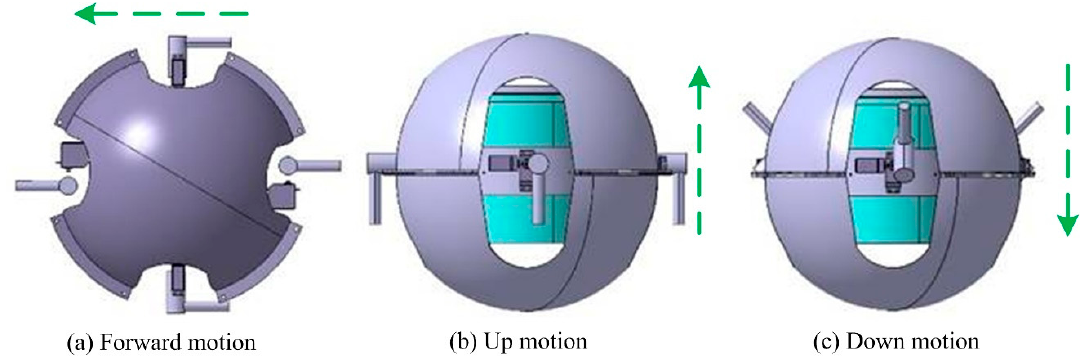
Figure 12. Simulation model of SURIII.